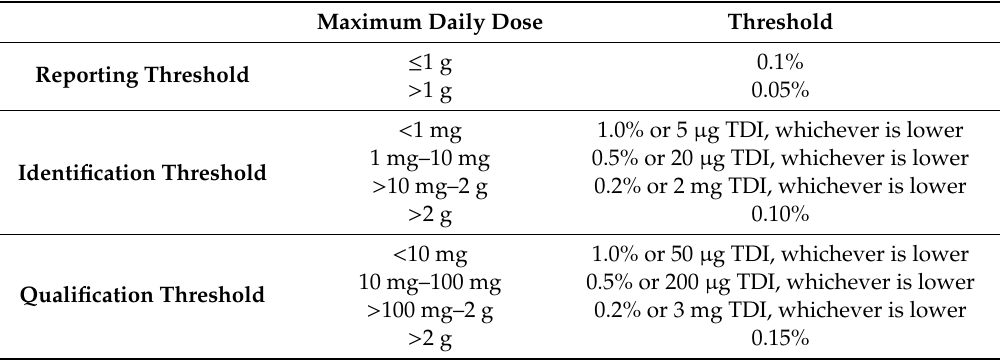
Table 2. Thresholds for degradation